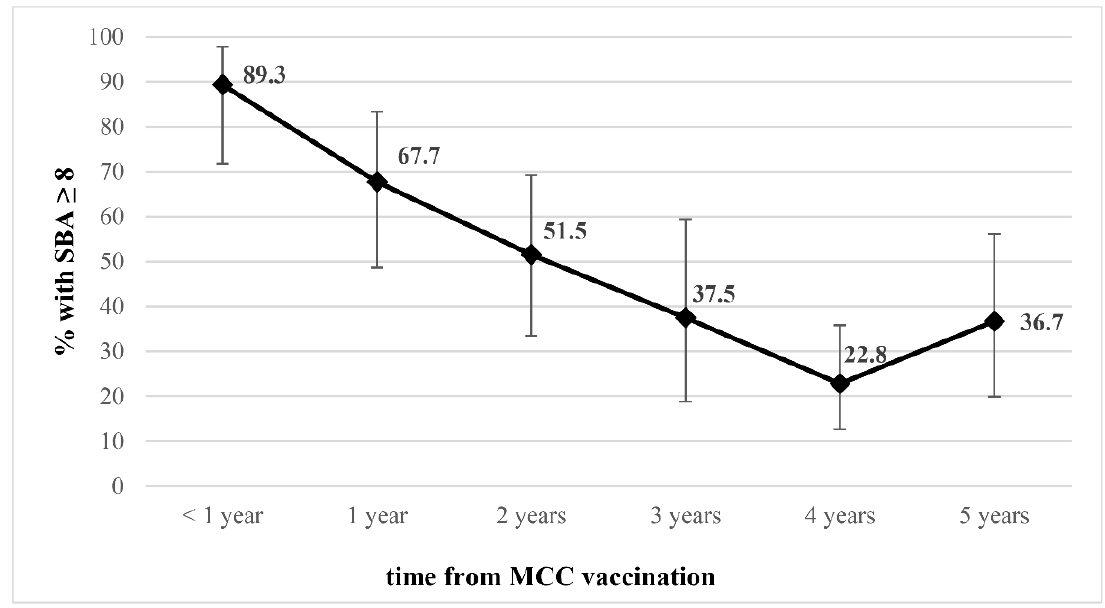
Figure 2. Percentage of children with serogroup C rSBA titers of ≥ 1:8 over time after MCC vaccination.